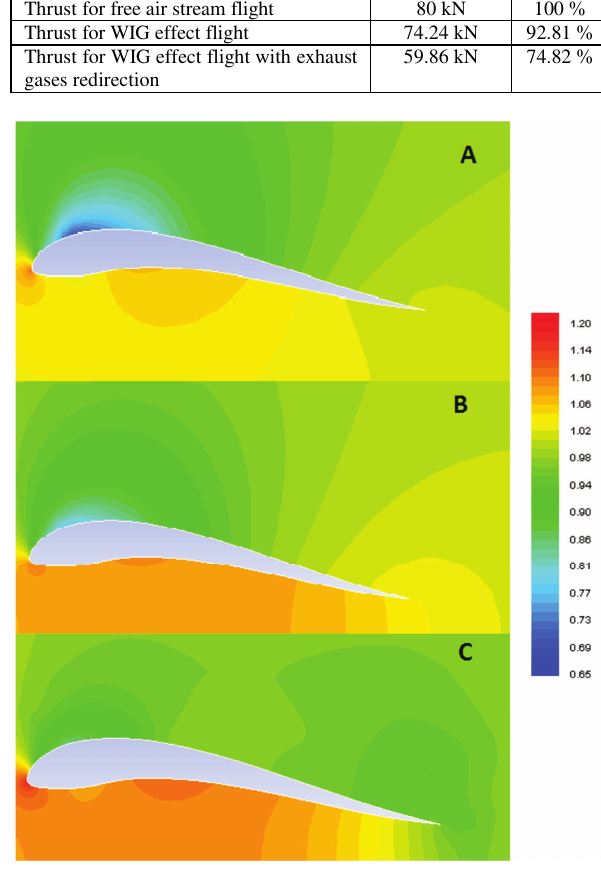
Fig. 6. Absolute pressure distribution: A – free stream flight; B – WIG effect flight; C – WIG with exhaust gasses redirection under airfoil